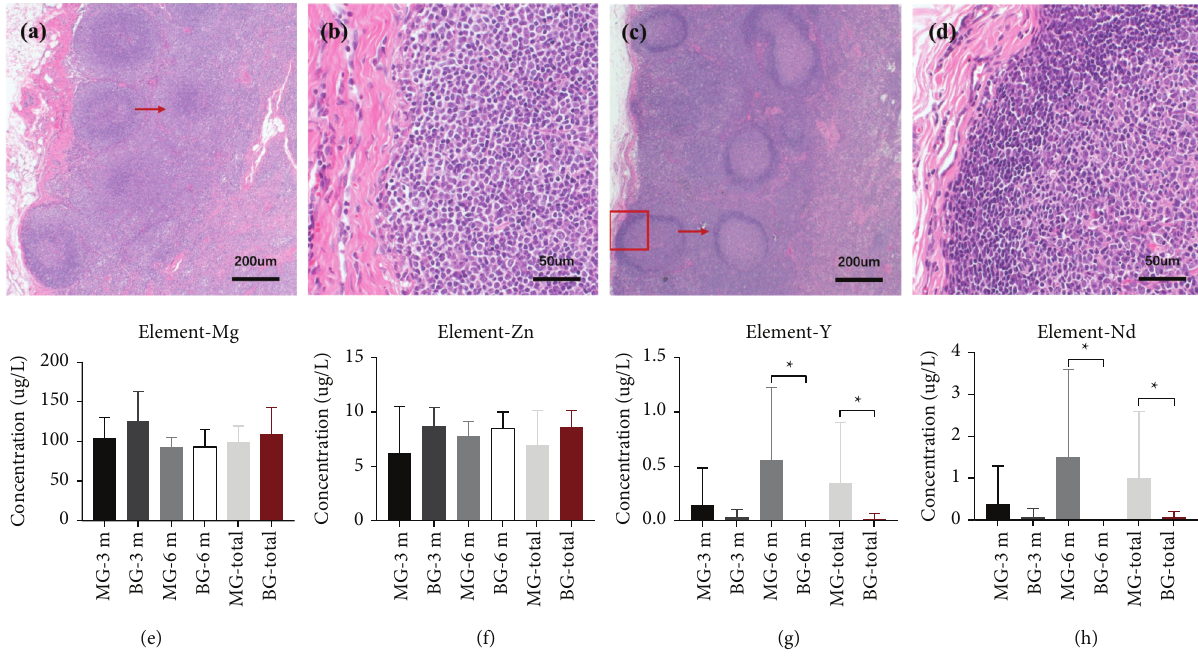
Figure 8: Histology and MG-related elemental analysis of submandibular lymph nodes. (a, b) Lymph nodes in the group MG-6 m. (c, d) Lymph nodes in the group BG-6m. Pathological changes (e.g., bleeding and local necrosis) were not found in either group. (e–h) Content of MG-related elements in different groups. ∗ P < 0 . 05, ∗ ∗ P < 0 .